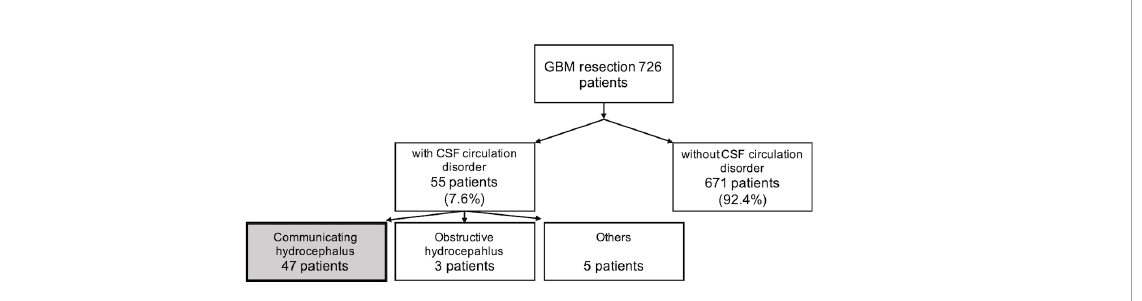
FIGURE 1 Incidence of different types of CSF circulation disorders in 726 GBM patients who underwent tumor resection between 2006 and 2019. 55 patients developed postoperative CSF circulation disorders, corresponding to an incidene of 7.6%. Of these, 47 had communicating hydrocephalus (CH; 6.5%), 3 had obstructive hydrocephalus (OH; 0.4%), and 5 had other types of CSF circulation disorders (such as hygroma or ventricular entrapment;